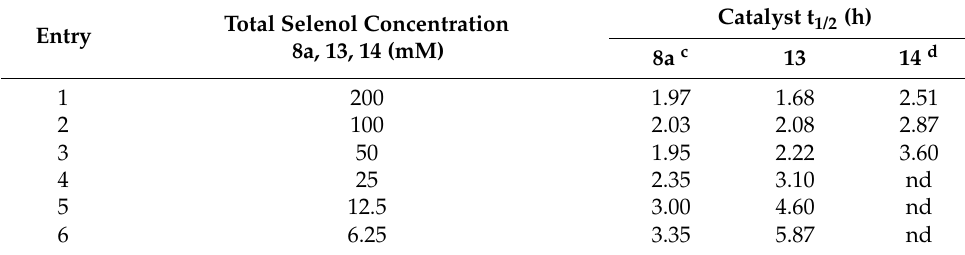
Table 1. Catalysis of bis (2-sulfanylethyl)amido (SEA)–thiol exchange using selenols 8a , 13 or 14 a,b .